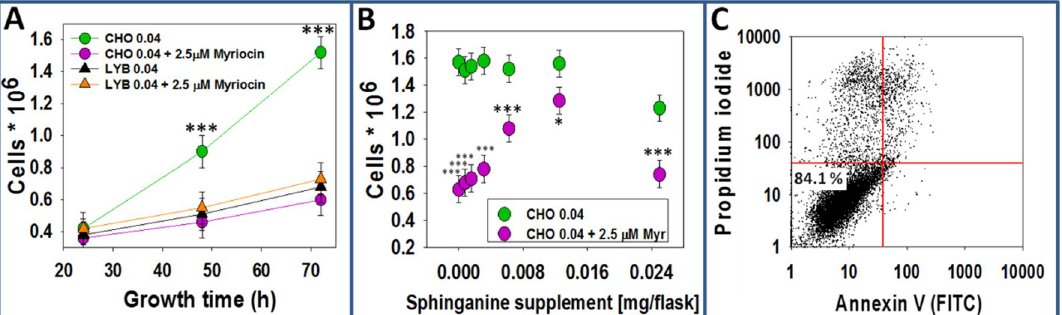
Figure 1. Myriocin-treated CHO and LY-B cell growth. ( A ) LY-B and CHO cell growth as a function of time in sphingolipid-deficient (0.04% FBS) medium, plus/minus 2.5 µM myriocin. Statistical symbols correspond to differences between green circles (CHO 0.04) and the other three samples; Student’s t-test *** P < 0.001. ( B ) Myriocin-treated and non-treated CHO cell growth after 72 h in sphingolipid-deficient medium supplemented with sphinganine (seeded cells: 0.25 × 10 6 ). Values are given as average values ± S.D. (n = 3). Significance, according to Student’s t-test, myriocin vs. control: * P < 0.05; *** P < 0.001. ( C ) A representative FACS assessment of cell viability of CHO cells after 72 h in sphingolipid-deficient medium plus 2.5 µM myriocin. Three independent experiments were performed counting 10,000 cells in each